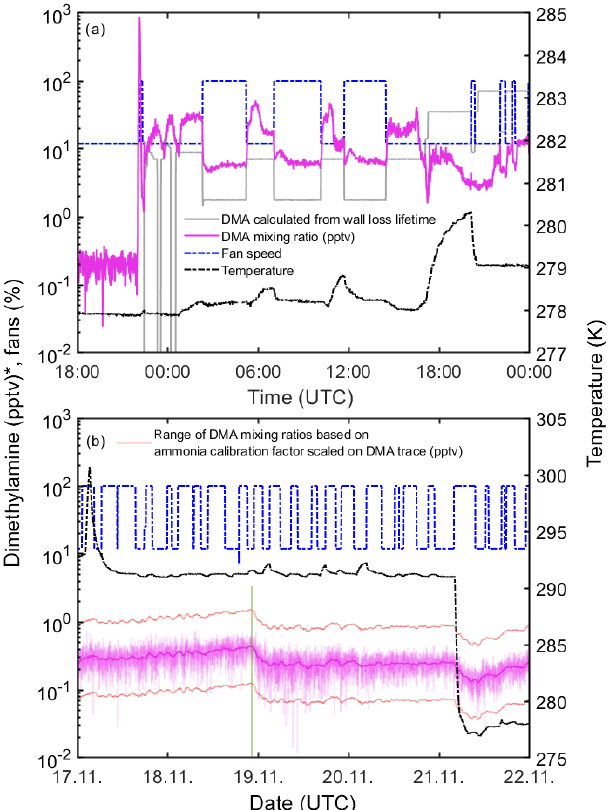
Figure 9. Dimethylamine mixing ratios (magenta line) during the CLOUD13 experiment. The dashed black line shows the tempera- ture inside the CLOUD chamber. The dashed blue line shows the fan speed. Panel (a) shows the dimethylamine signal during active injection into the chamber. The grey line indicates the dimethy- lamine mixing ratio in the chamber calculated from the MFC set- tings and the wall loss lifetime. The upper limit for the uncertainty in the dimethylamine mixing ratio is a factor of ∼ 3 . 5 (see the text for details). Panel (b) shows a measurement of background dimethylamine in the chamber over a period of 5d, when there was zero dimethylamine flow. We consider this to be due to in- strumental background and not to an actual dimethylamine back- ground in the chamber. The thin red lines show the possible range of dimethylamine based on the scaled calibration factor (factor of 3.48, 95% CI). The thick magenta line indicates a moving av- erage of the dimethylamine background measurement. The water source was replenished during the period shown (green line). The mean instrumental background of dimethylamine over this period is ∼ 0 . 14pptv. ∗ Note that the dimethylamine mixing ratio is deter- mined with the calibration factor for